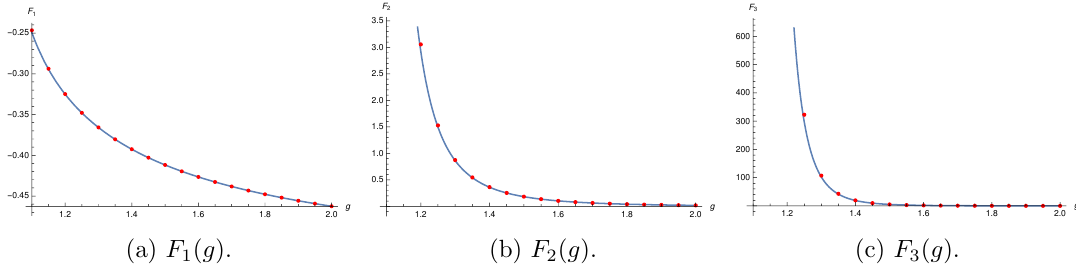
Figure 2. Plot of the genus- ‘ free energy F ‘ ( g ) for ‘ = 1 ; 2 ; 3 in the gapped phase ( g > 1). The dots are the values obtained from the exact free energy log Z ( N; g ) for N = 100 using (2.12), while solid curves represent the analytic form of F ‘ ( g ) in